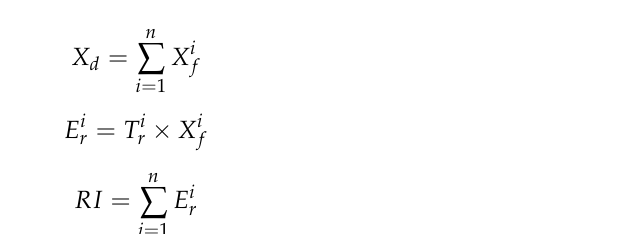
Table 3. Classification of X i